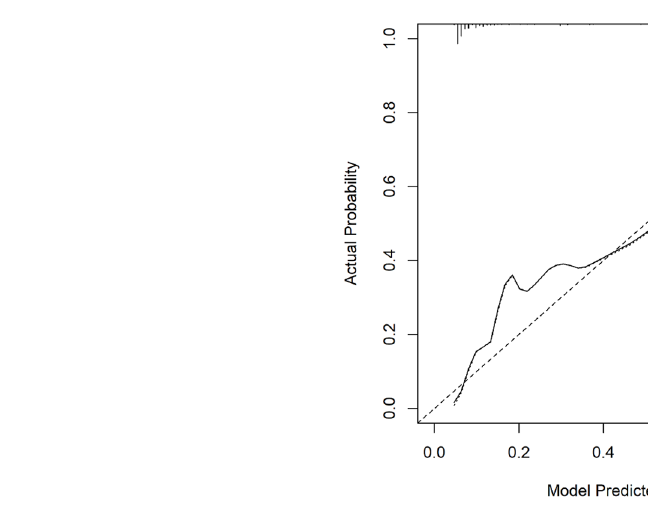
FIGURE 4 Calibration curve analysis for predicting rapid relapse in the validation set.